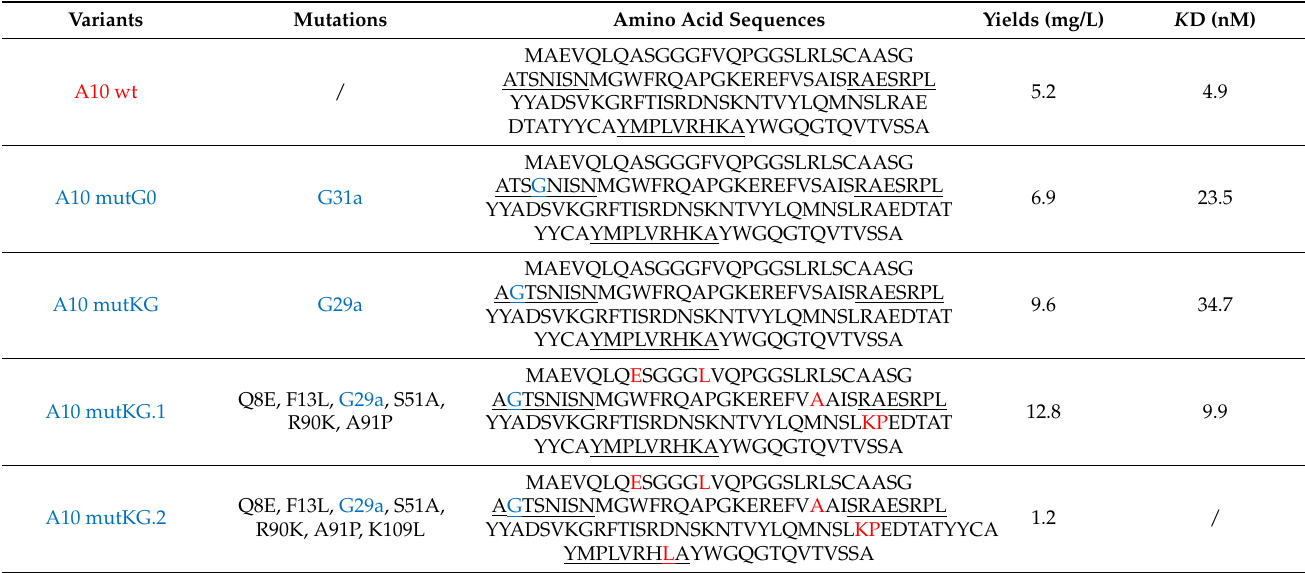
Figure 2. Molecular dynamics analyses. ( a , b ) Backbone root mean squared deviation (RMSD), ( c , d ) backbone radius of gyration (RMSF), ( e , f ) backbone root mean squared fluctuation, ( g , h ) overlap of conformations sampled every 100 ns, and ( i – n ) CDRs RMSD. ( a , c , e , g , i – k ) refer to A10 wt, while ( b , d , f , h , l – n ) refer to A10 mutG0. Color code: CDR1 (cyan), CDR2 (violet), CDR3 (green). Table 1. Characteristics of the clones used in the simulations and experiments. CDRs are underlined, point mutations are in red, and insertions in